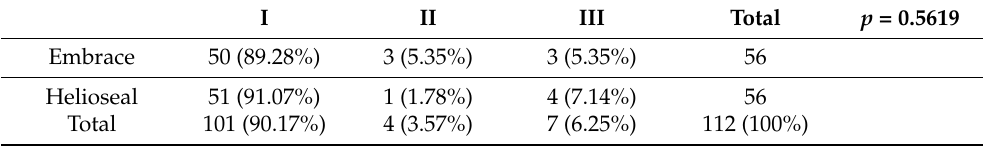
Table 2. Assessment of sealant retention after 12 months according to Simonsen’s